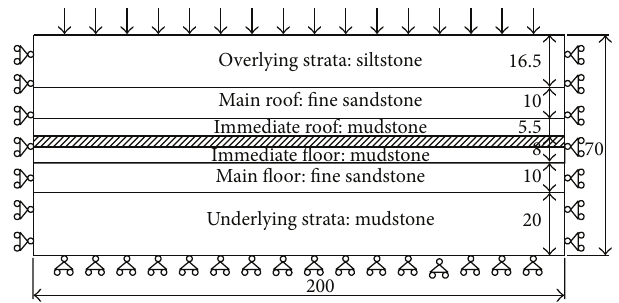
Figure 5: Numerical simulation